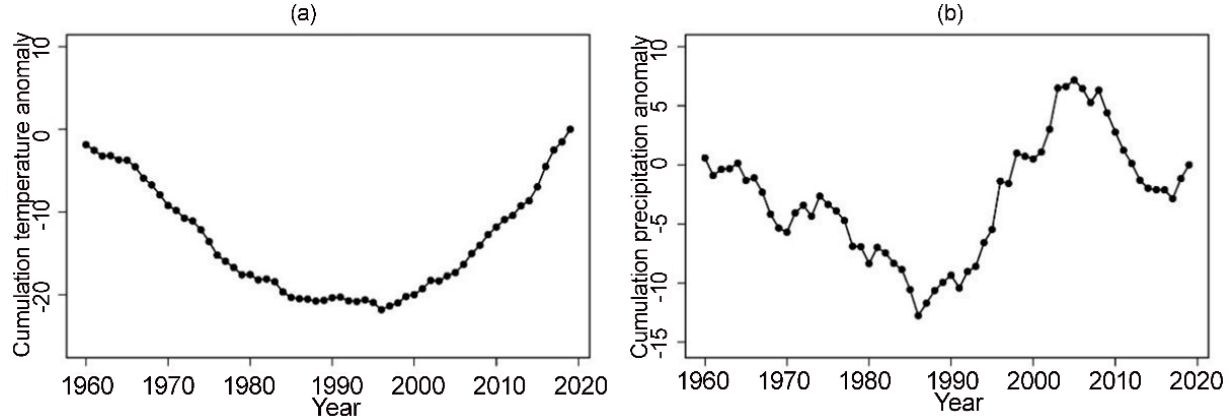
Figure 6. Annual average temperature ( a ) and precipitation ( b ) cumulation anomaly curves in the Turpan region from 1960 to 2019.